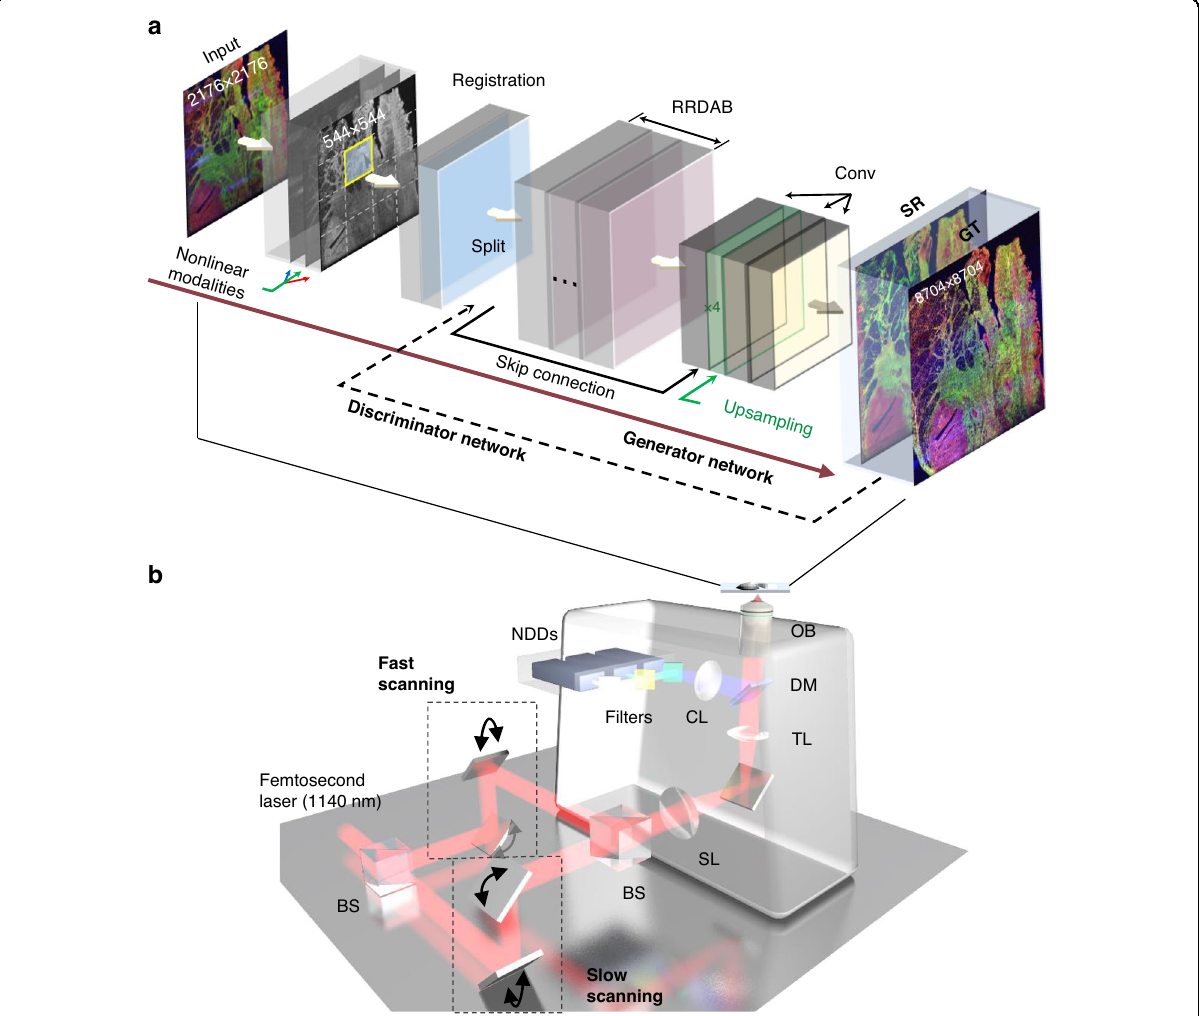
Fig. 1 DLAM schematic. a The basic network architecture including registration, RRDAB modules, conv layers, the skip connection, upsampling operation, and discriminator. The full frameworks can be found in the section “ Materials and methods ” , Notes S1 – 4, and Figs. S1 – 4. b A commercial two-photon microscope with a fast galvo-resonant scanning system and a slow dual-axis galvo scanning system. BS beam splitter, CL collect lens, DM dichroic mirror, NDD nondescanned detectors, OB objective, SL scan lens, TL tube